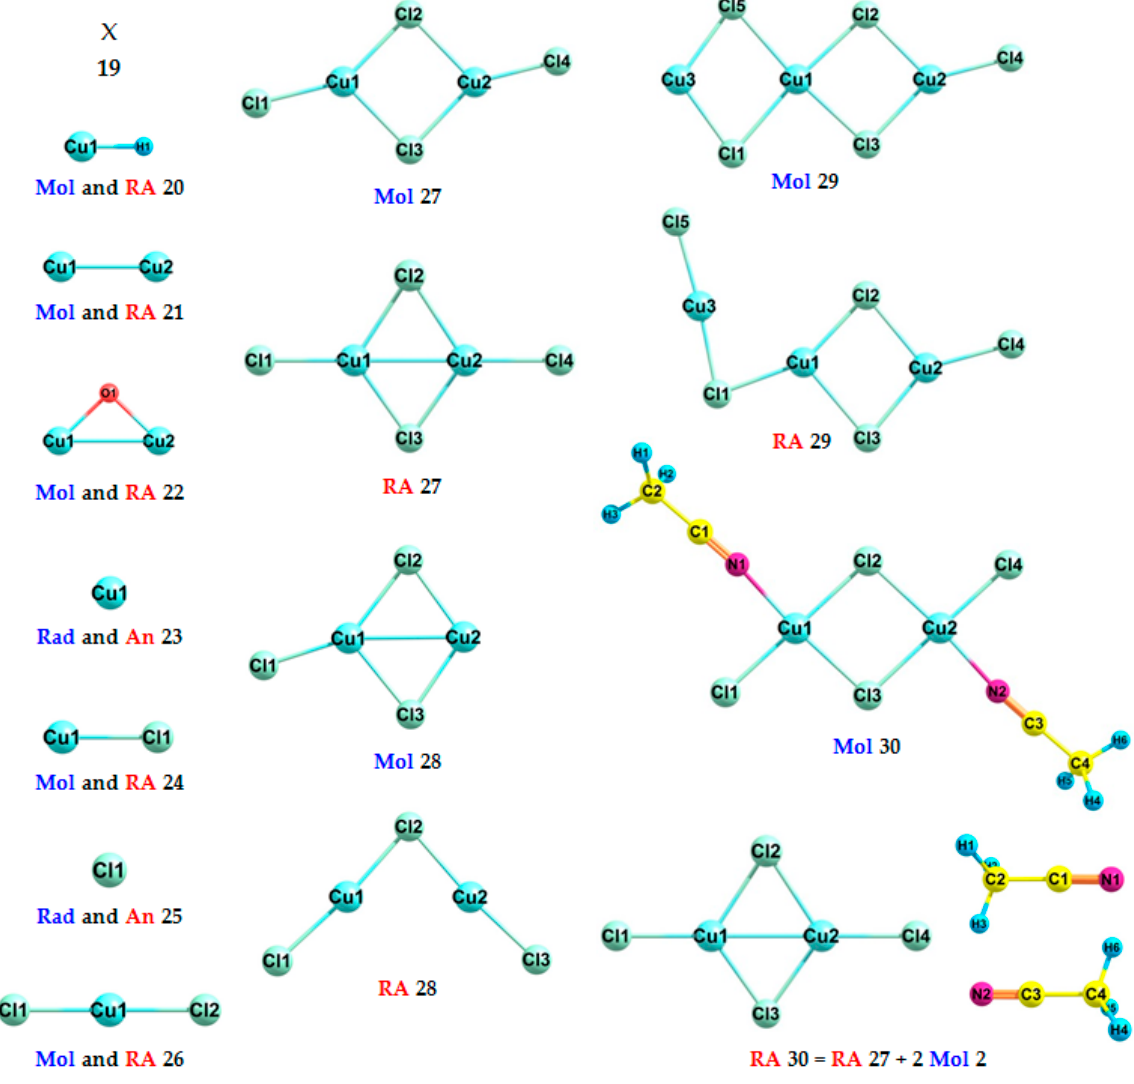
Figure 5. The DFT calculated molecules ( Mol ), radicals ( Rad ), radical anions ( RA ), and anions ( An ).